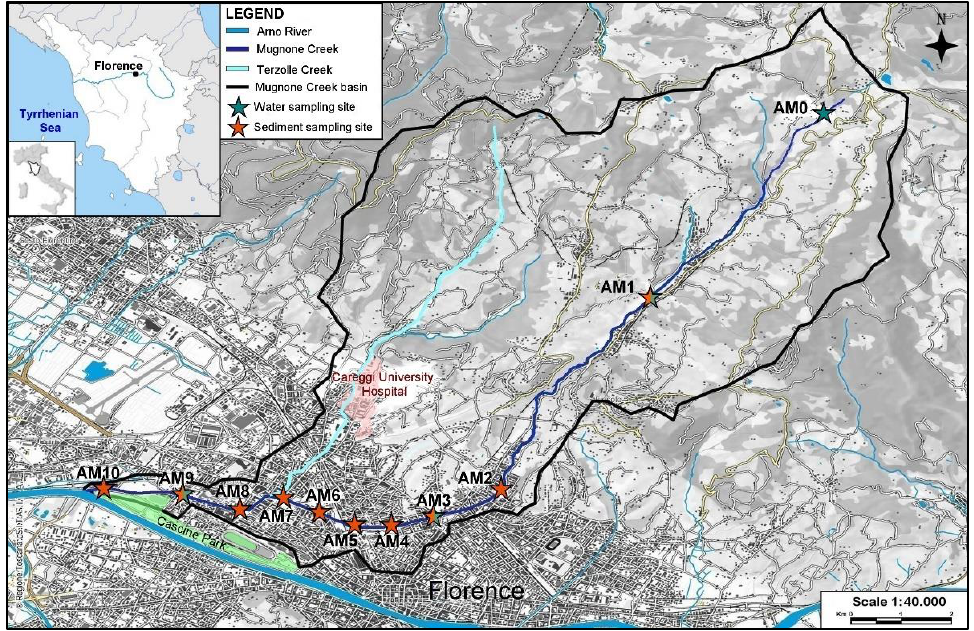
Figure 1. The urban area of Florence (Italy) and the location of sampling sites along the MC. Sediments from MC were collected in June 2019 at 10 locations, moving from upstream of the Florence urban center (AM1–AM2) to the outlet into the Arno River (Figure 1). One sample (AM8) was collected just after the confluence with the Terzolle Creek to assess the impact of the hospital on the polymer pollution. Sediments were collected as grab samples with a metal scoop and stored in 1 L glass jars. In the laboratory, sediments were dried for two weeks at room temperature, covered with aluminum foil, and then sieved (metal sieve) at <2 mm to separate the finer fraction, which was investigated for MPs and natural fibers. Water sampling was repeated seasonally (June–September) for two years (2019–2020) at 3 of the 10 sediment collection sites (AM1, AM2, AM3). Upon considerations of the preliminary results from the 2019 sampling (see later), an additional site (AM0), further upstream of the Florence urban center (i.e., next to the MC spring), was sampled and characterized for micropolymers. River water (1–3 L) was collected 0–30 cm below the surface in triplicate using glass bottles pre-cleaned with acid, washed three times with stream water before sampling. Samples were stored in a dark place, at ~4 ◦ C, until analysis. During water sampling, flow discharge was measured simultaneously at AM1, AM3, and AM9 by tracer dilution methods [42]. Daily fluxes (items/day) of synthetic and natural micropolymers at each site were calculated by knowing the number of items per cubic meter (items/m 3 ) and the flow rate (m 3 /s) considered constant for 24 h at each